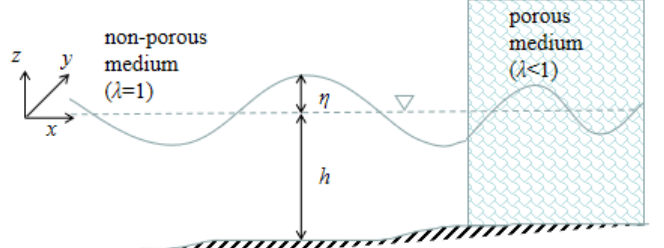
Figure 1. Sketch of wave propagation in porous media.